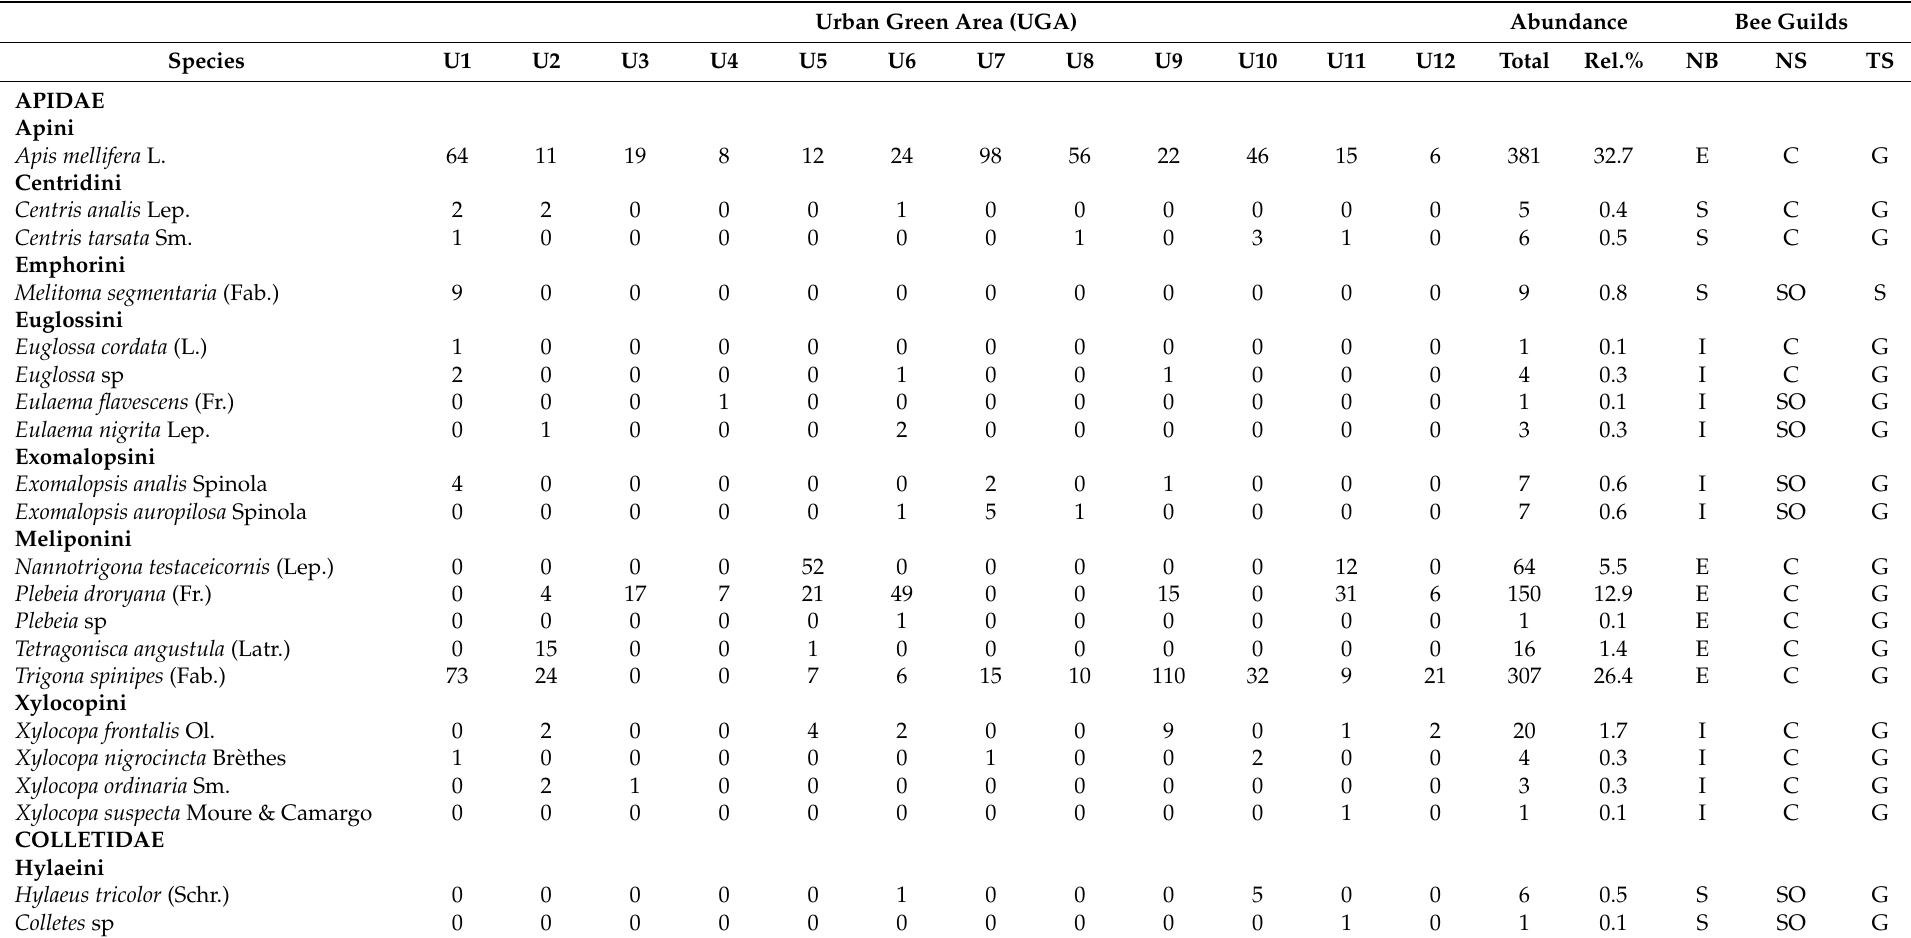
Table 1. Abundance of bee species collected on flowers with an entomological net at 12 Urban Green Areas (UGA) in Campos dos Goytacazes, RJ, Brazil, and respective biological characteristics: Nesting Behavior (NB)—Solitary (S), Eusocial (E), Intermediate (I); Nesting Site (NS)—Soil (SO), Cavity (C); Trophic Specialization (TS)—Generalist (G), Specialist